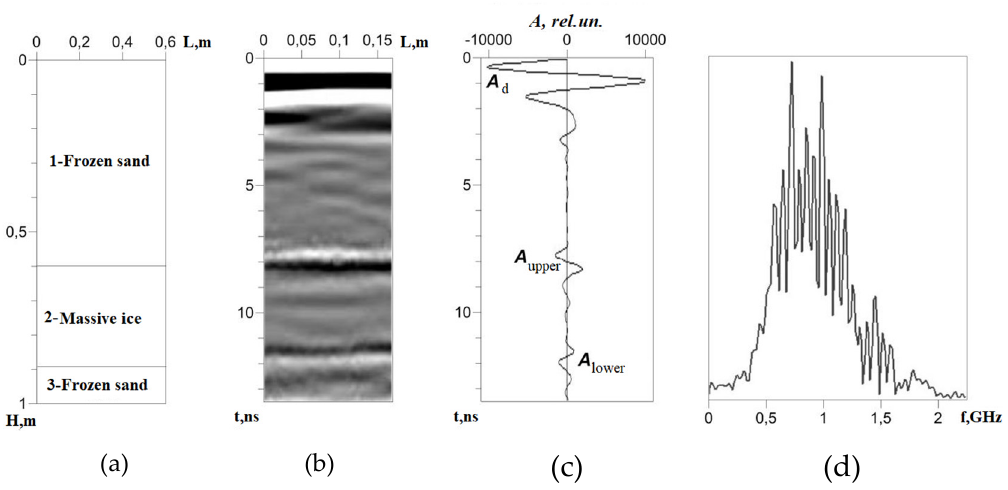
Figure 10. The scheme of a physical model of massive ice ( a ) and results of GPR profiling: fragment of a radargram ( b ), averaged trace ( c ), spectrum of a radargram ( d ).